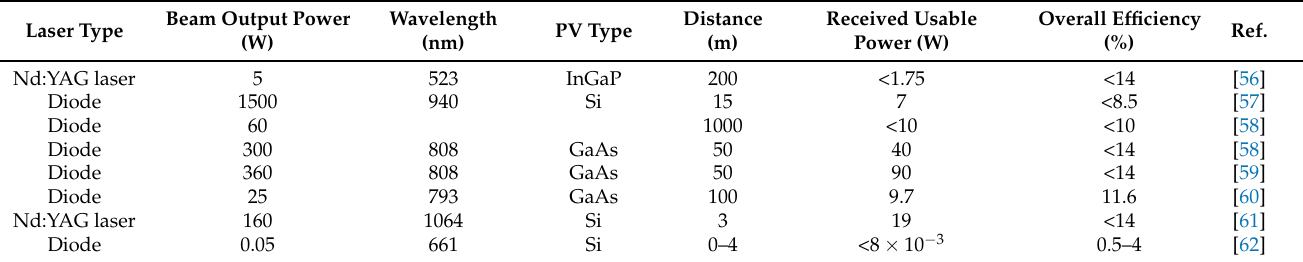
Table 2. Summary of a selection of LPT realizations in the